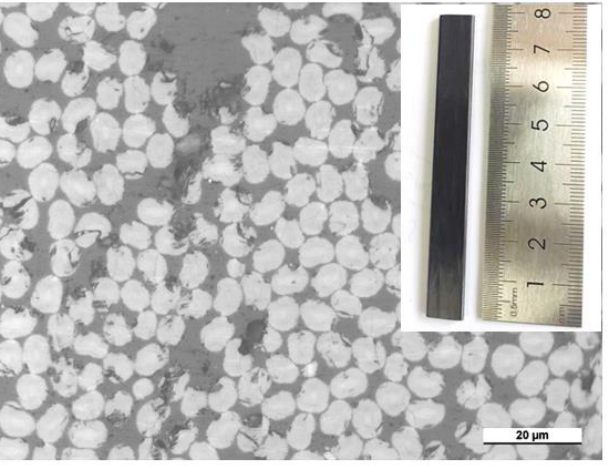
Figure 1. The optical image of the cross-section of the CFRE plate (inset its digital image).